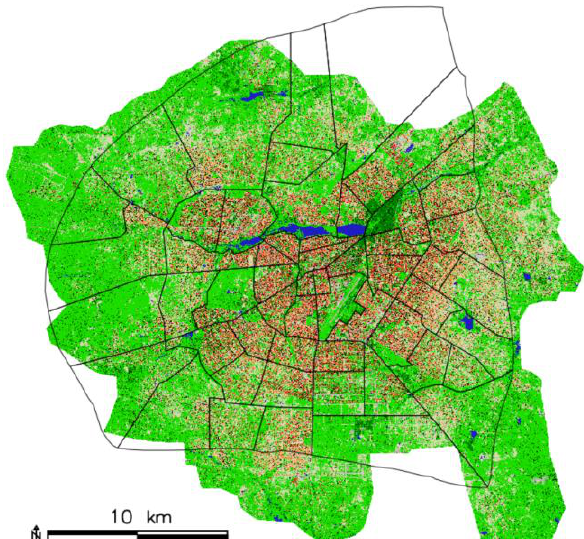
Figure 8 . Spatial coverage of the administrative zones by the LC dataset,